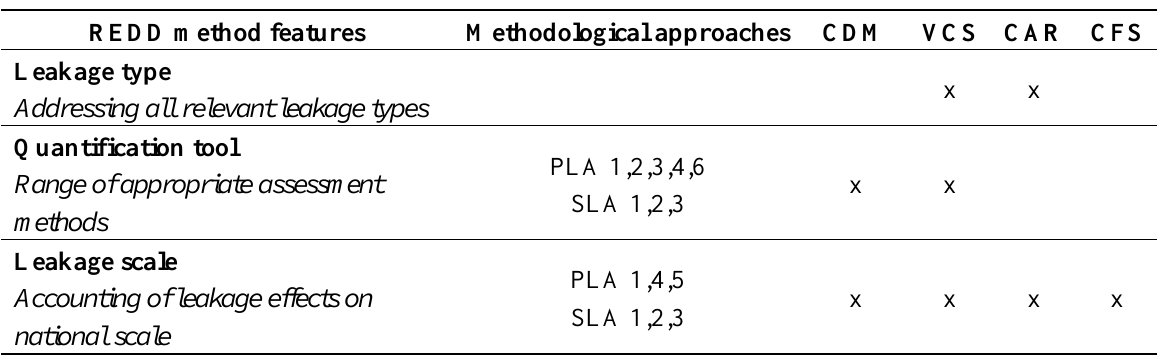
Table 5. Leakage methods grouped by carbon accounting standards screened for fulfilling important leakage features in a future REDD mechanism. CDM—Clean Development Mechanism, VCS—Verified Carbon Standard, CAR—Climate Action Reserve, CFS—Carbon Fix